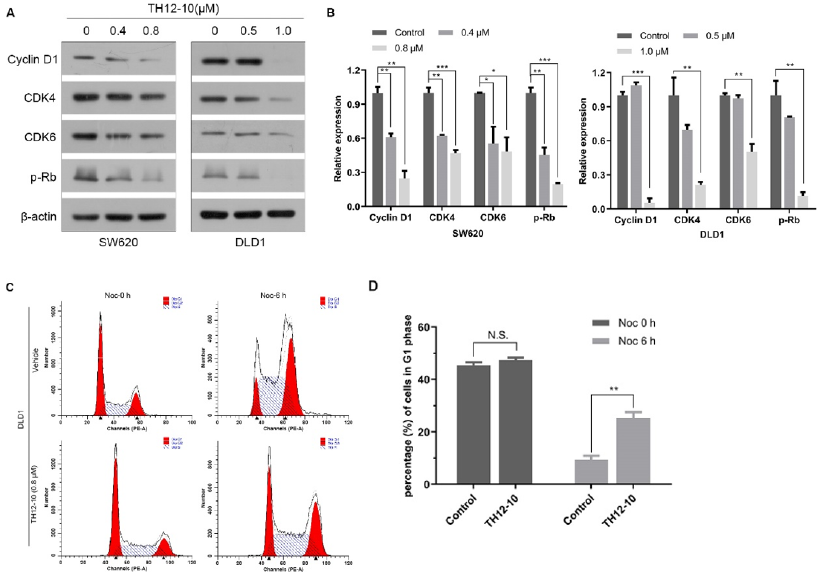
Figure 3. TH12-10 blocks S phase entry. ( A ) Immunoblot analysis of Cyclin D1, CDK4, CDK6, and p-Rb in SW620 and DLD1 cells treated with indicated concentrations of TH12-10 for 48 h. ( B ) Densitometry analysis of indicated proteins as described in ( A ) was performed using Image J software. ( C ) Flow cytometric analysis for cell-cycle distribution in DLD1 cells treated with TH12-10 or vehicle and then with nocodazole for 48 h. ( D ) Quantitative analysis of DLD1 cells in G1 phase as described in ( C ). All data are presented as means ± SD of three independent experiments. * p < 0.05, ** p < 0.01, *** p < 0.001. N.S., not significant. Differences were tested using one-way ANOVA ( B ) or the unpaired t-test with Welch’s correction ( D ).